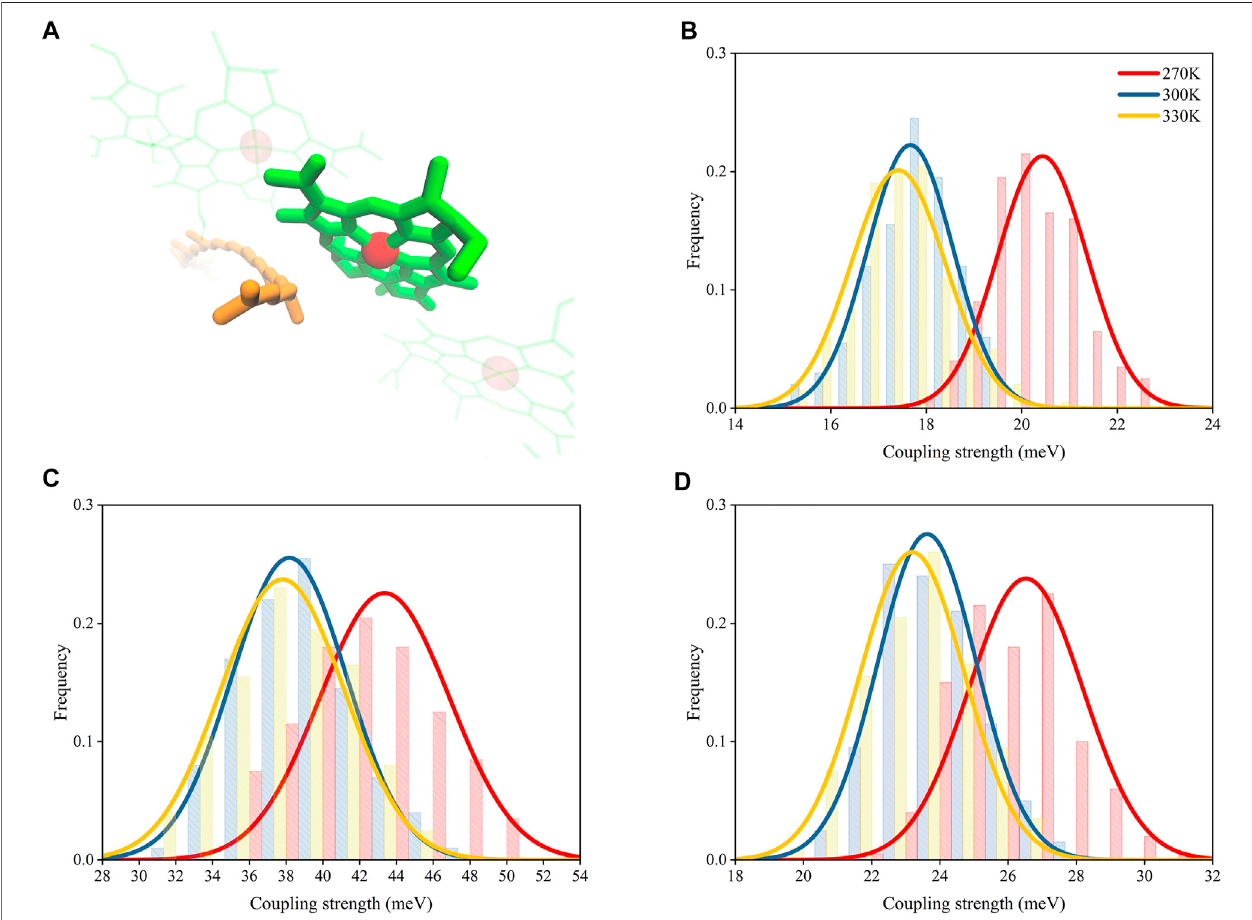
FIGURE 6 | Distributions of coupling strength between RG1 and B850 molecules under different temperatures. (A) Representative structures of RG1 and B850. Coupling strengths calculated with PDA (B) , BDF (C) , and EET analysis (D) .